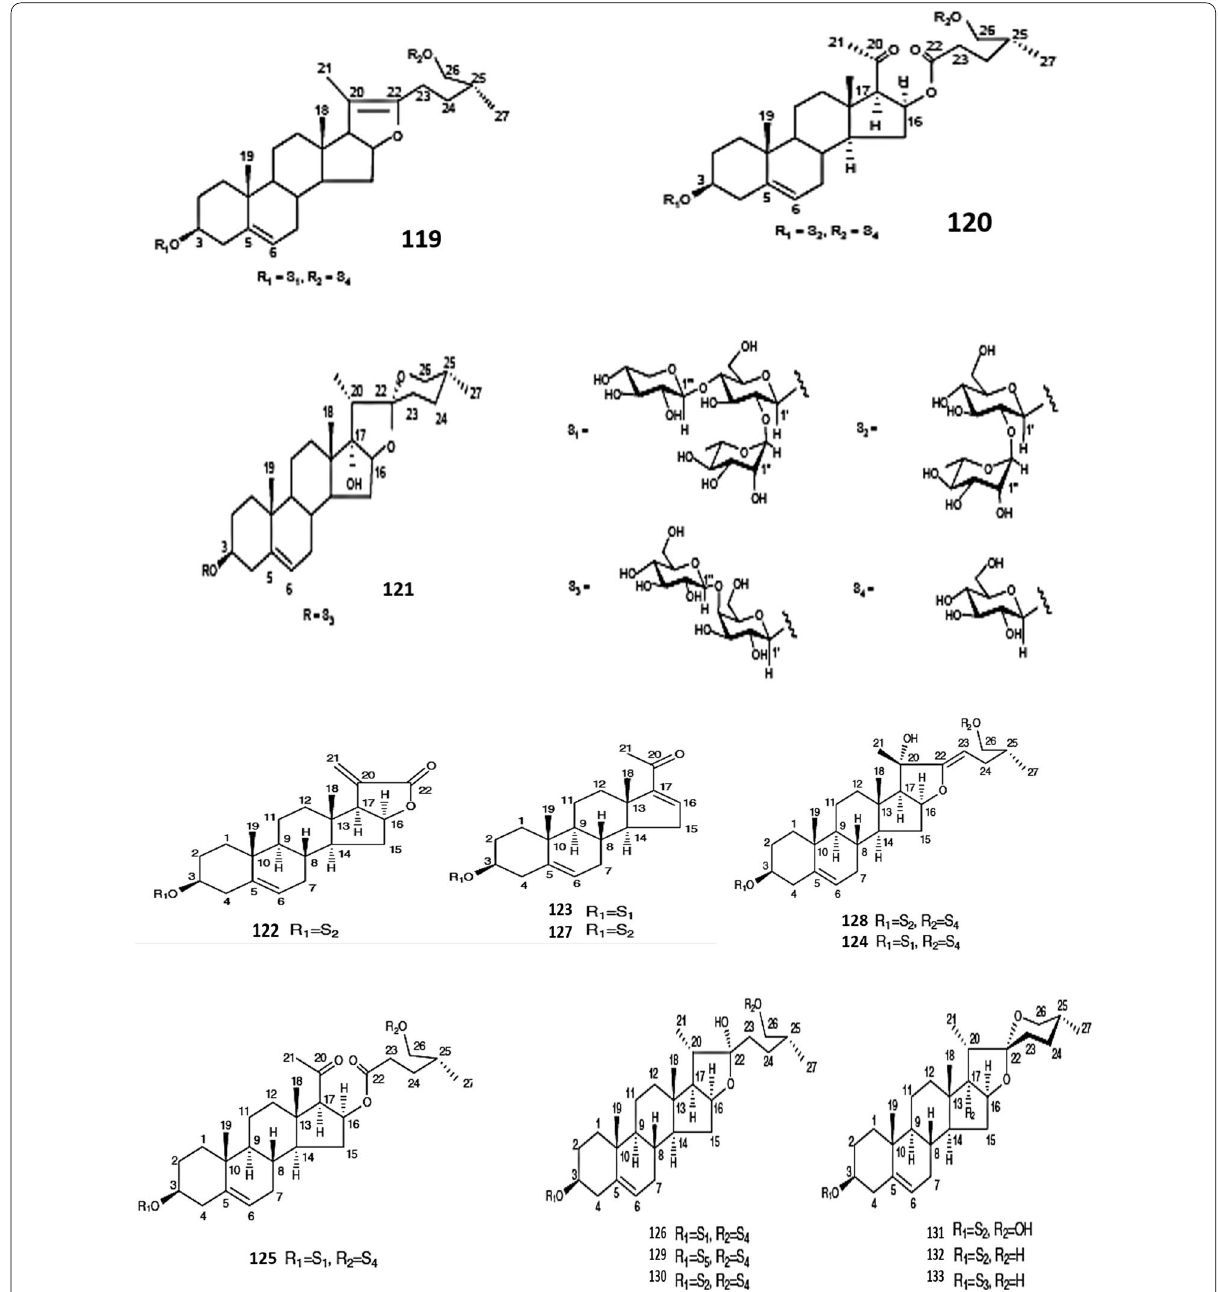
Fig. 3 Structures of various other chemical compounds of genus Fritillaria : 119. pallidiflosides A, 120. pallidiflosides B, 121. pallidiflosides C, 122. pallidiflosides D, 123. pallidiflosides E, 124. pallidiflosides G, 125. pallidiflosides H, 126. pallidiflosides I, 127. spongipregnoloside A, 128. smilaxchinoside C, 129. timosaponin H1, 130. protobioside, 131. polygonatoside B3, 132. polyphyllin V, 133. deltonin, 134. parispseudoside B, 135. (25R)- 26-[β-D-glucopyranosyl]oxy]-3β-[(O-α-Lrhamnopyranosyl-(1/2)- β-D-glucopyranosyl)oxy]-cholesta-5,17-diene-16,22-dione, 136. (22S,25S)- 26-O-β-D-glucopyranosyl-22, 25-epoxyfurost-5-en-3β, 26-diol-3-O-[α-Lrhamnopyranosyl(1/2)]-β-D-glucopyranoside, 137. 26-O-β-D-gluc opyranosyl-3,26-dihydroxy-(25R)- 5β-furost-12-on-20(22)- ene-3-O-α-L rhamnopyranosyl-(1/2)- β-D-glucopyranoside, 138. aspidistrin, 139. gastrodin, 140. 4-(β-D-glucopyranosyloxy) benzoic acid, 141. icariside D2, 142. uridine, 143. adenosine, 144. uracil, 145. (S)- β-L-phenylalanine, 146. arginine, 147. lysine, 148. tryptophan, 149. tyrosine, 150. histidine, 151. isoleucine, 152. glycine, 153. leucine, 154. valine, 155. oxyproline, 156. alanine, 157. glutamate, 158. threonine, 159. proline, 160. methionine, 161. serine, 162. aspartate, 163. cysteine, 164. phenylalanine, 165. ornithine, 166. meristic acid C14:0, 167. pentadecanoic acid C15:0, 168. palmitic acid C16:0, 169. palmitoleic acid C16:1, 170. stearic acid C18:0, 171. oleic acid C18:1, 172. linoleic acid C18:2, 173. linolenic acid C18:3, 174. α -monopalmitin, 175. diosmetin, 176. murrayone, 177. 1-O-β-D-glucopyranosyl-(2S,3R,4E,8Z)-2-[(2-hydroxyoctadecanoyl) amido]-4, 8-octadecadiene-1,3-diol, 178. fritenolide A, 179. fritenolide B, 180. fritenolide C, 181. fritenolide D, 182. fritenolide